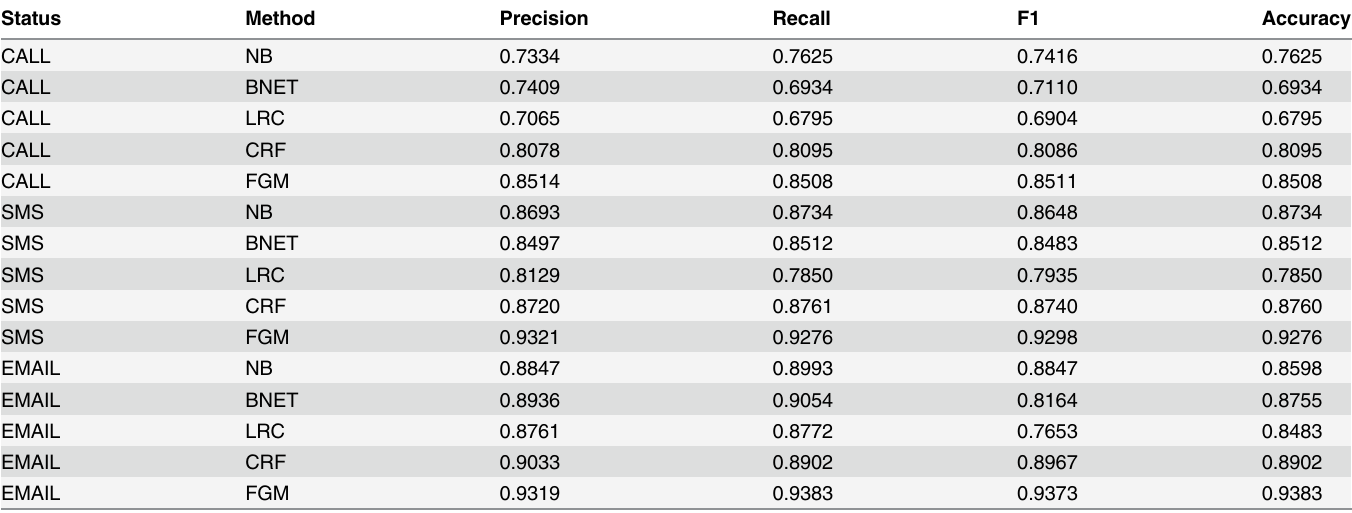
Table 4. Social status prediction in enterprise communication networks. NB: Naive Bayes, BNET: Bayes Network, LRC: Logistic Regression Classifica- tion, CRF: Conditional Random Fields, FGM: Factor Graph